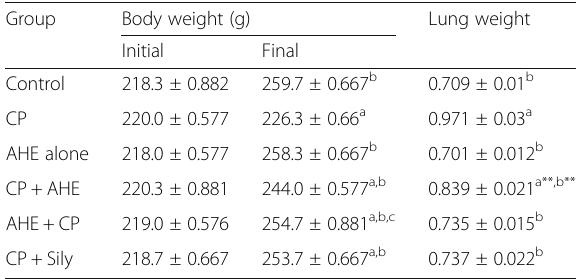
Table 1 Effect of cisplatin and/or AHE treatment on body weight and lung weight of